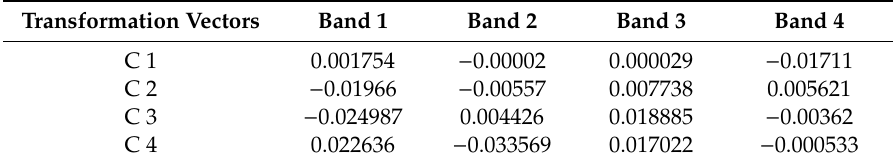
Table 5. Transformation vectors of minimum noise fraction (MNF) analysis on a spectral subset of the ASTER data for detecting gossans in the study